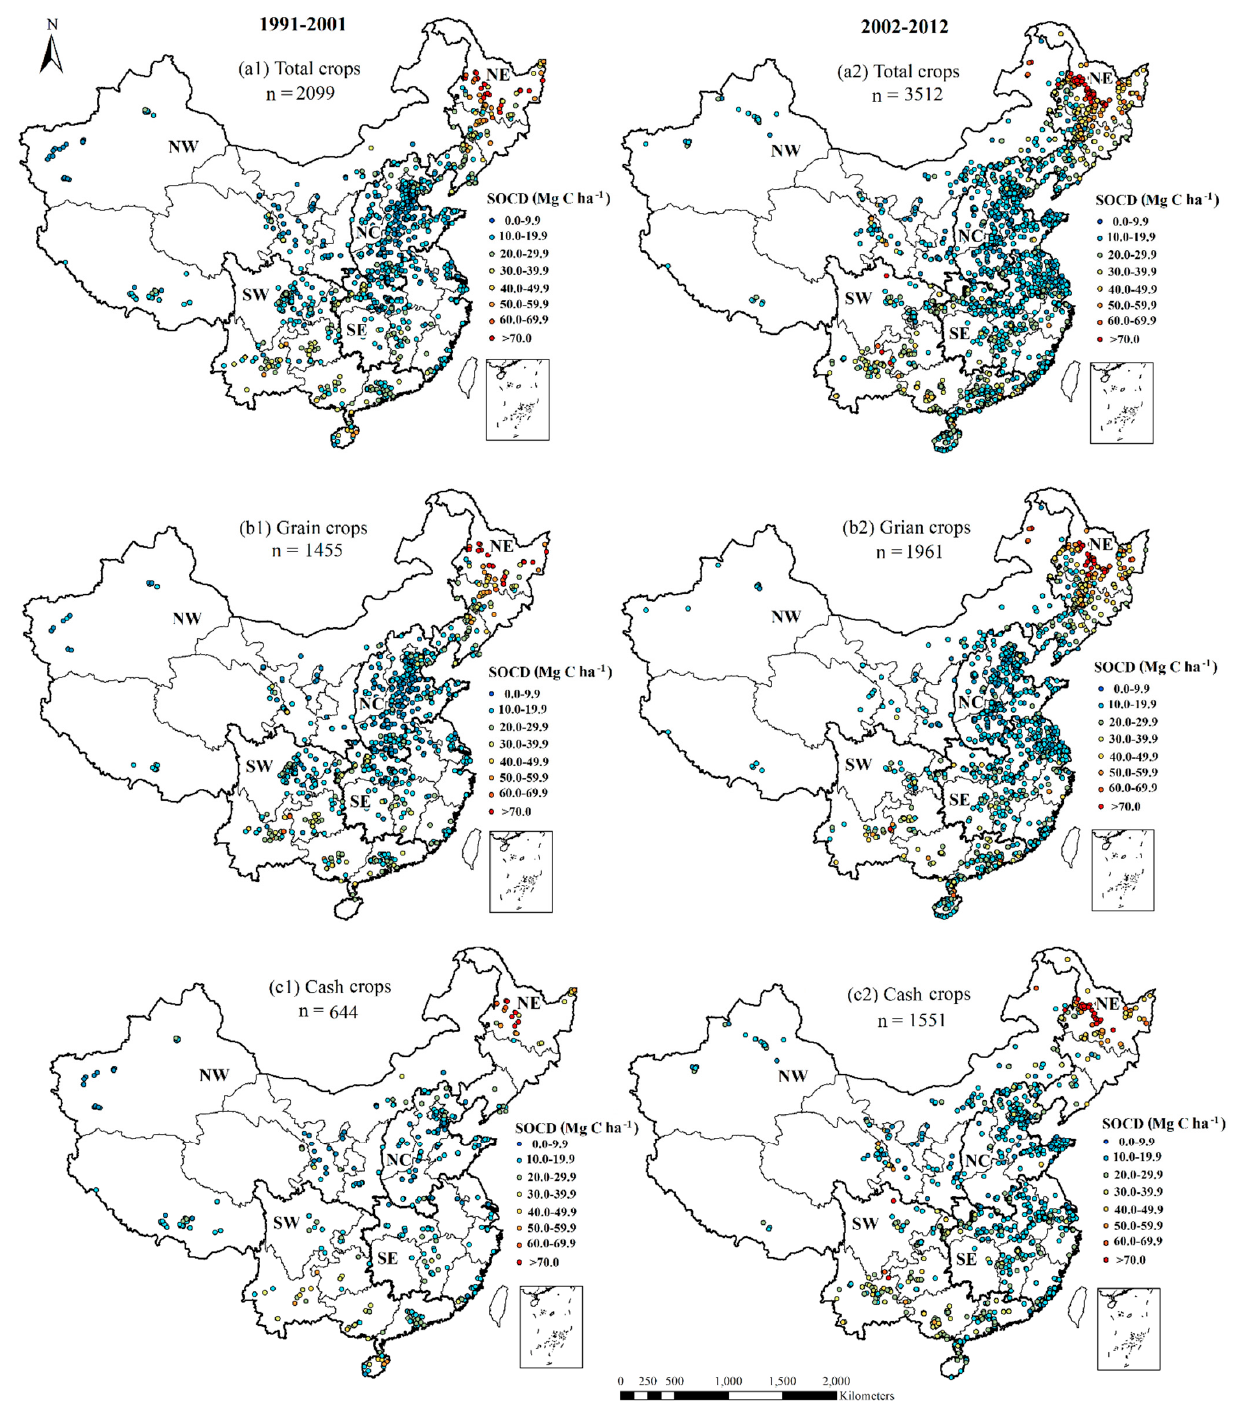
Figure 4. Geographical variation of soil organic carbon density (SOCD) for ( a1 , a2 ) total crops, ( b1 , b2 ) grain crops and ( c1 , c2 ) cash crops in China’s croplands between 1991–2001 and